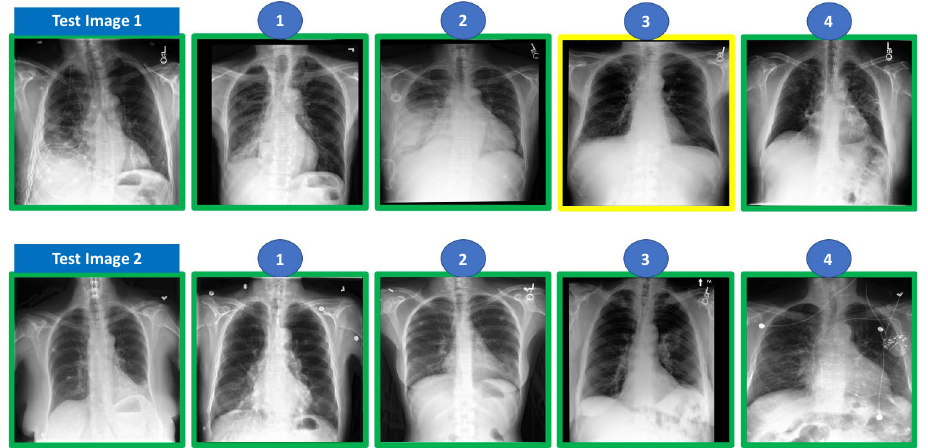
Figure 3. Example of test cases and ranking annotation for potential pneumonia condition (the top 4 are shown) performed by the radiologist. The numbers on top of the image represent the ranking position of the image in the catalogue (when compared to the query/test image). The green box means pneumonia case (according to the dataset label), yellow box means radiologist considers case as potential pneumonia and dataset label is no pneumonia.